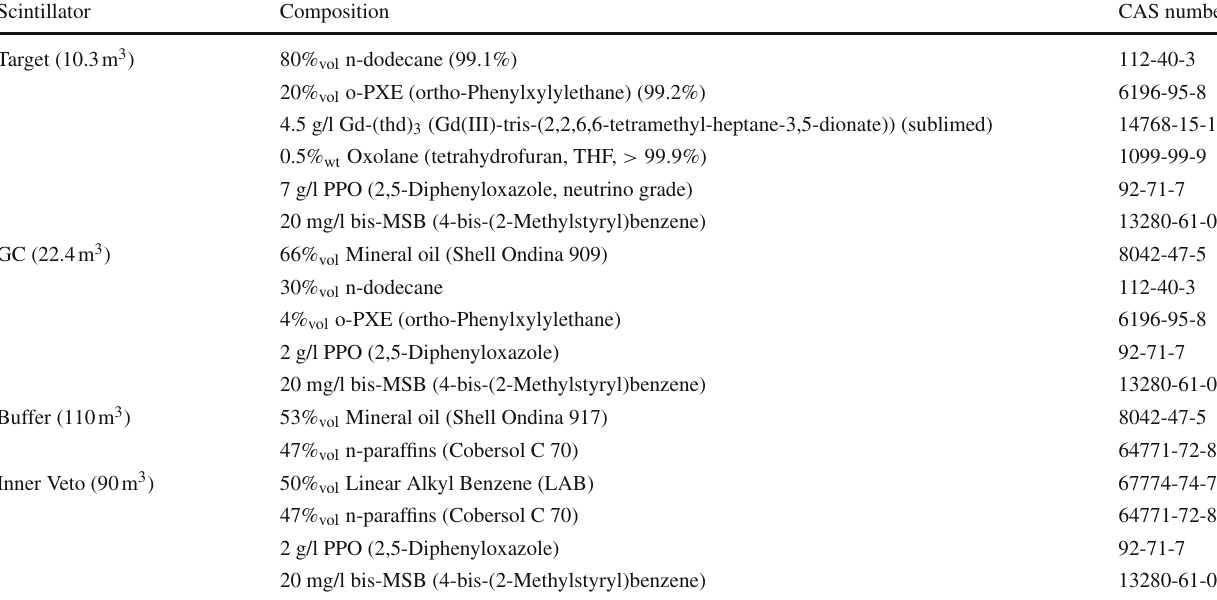
Table 1 Composition and volumes of the Double Chooz Target and Gamma catcher scintillators (far detector) Scintillator